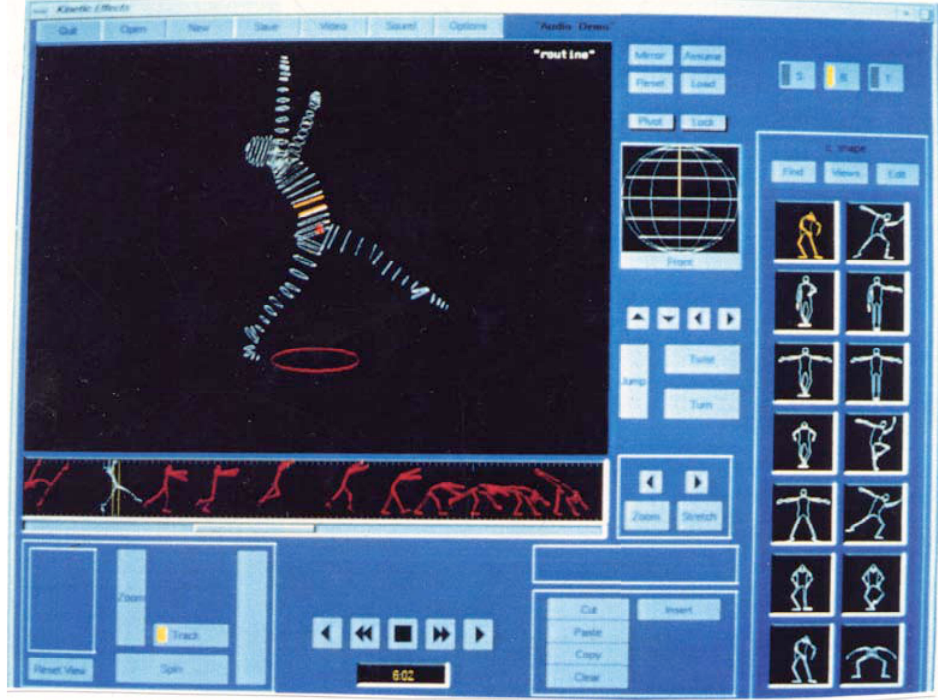
Figure 3.4 -- The Sequence Editor